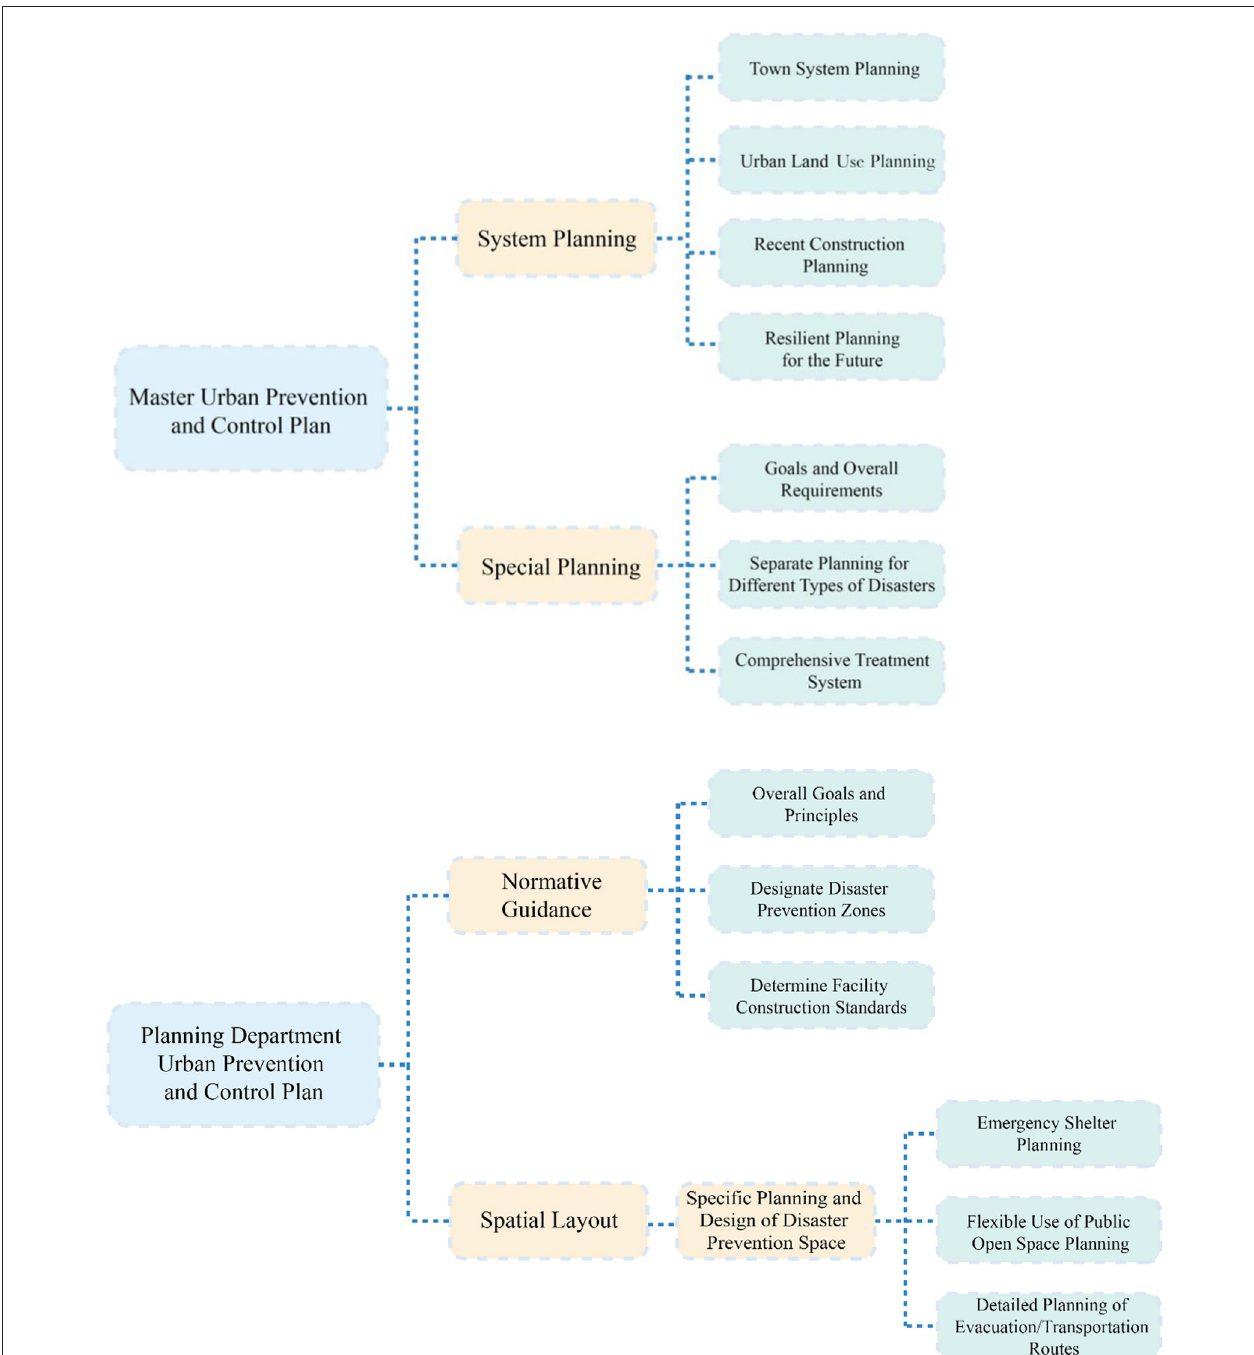
FIGURE 9 | Flexible disaster prevention and control planning (Source: